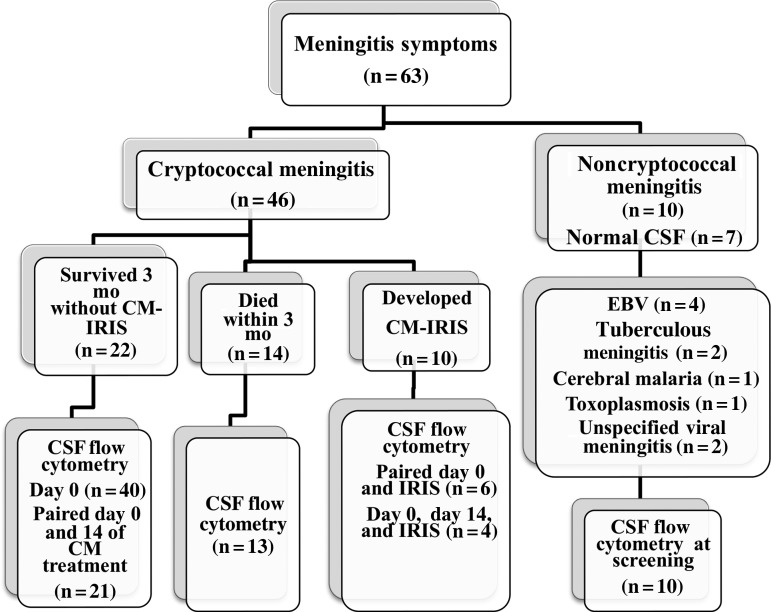
Study flow diagram. Distribution of subjects with suspected meningitis and etiology of meningitis in a nested cohort of human immunodeficiency virus-infected subjects in the Cryptococcal Optimal Antiretroviral Timing (COAT) trial and Neurological Outcomes on ART (NOAT) study in Mulago National Referral Hospital, Kampala, Uganda. Abbreviations: CM, cryptococcal meningitis; CSF, cerebrospinal fluid; EBV, Epstein-Barr virus; IRIS, with immune reconstitution inflammatory syndrome.